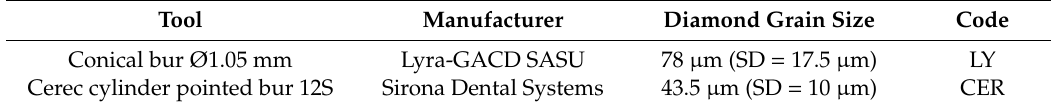
Table 2. Tools used in the study. (SD: Standard Deviation).